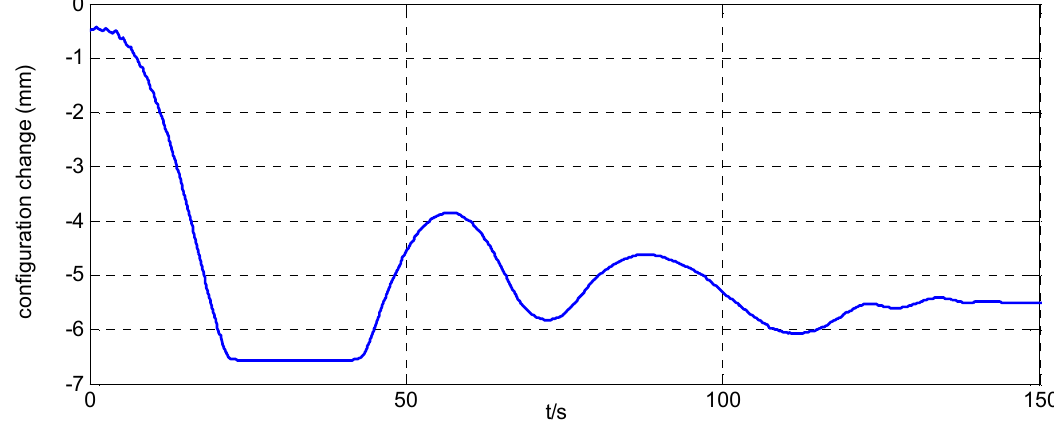
Figure 20. Relative angle error inside the simulator when x ( 0 ) = 874mm.